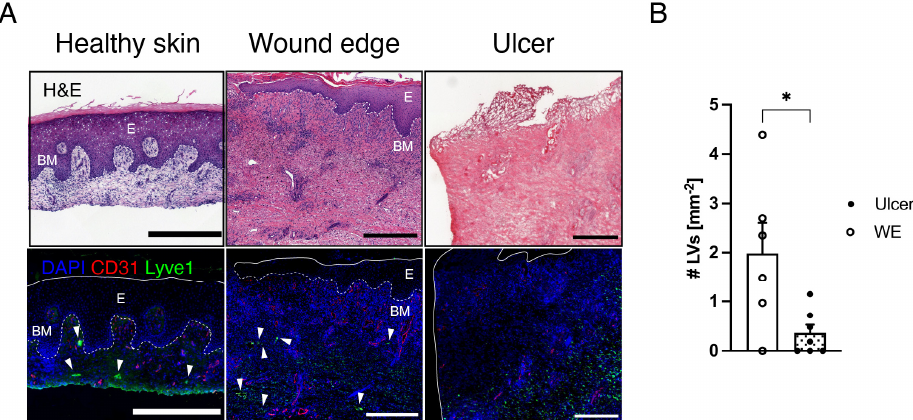
Figure 1. Lymphatic vessels are largely absent in human chronic ulcers. ( A ) Representative H&E and LYVE1 and CD31 stained sections of human healthy skin, wound edge, and ulcer of a chronic wound. Healthy skin is characterized by a continuous basal membrane. The adjacent wound edge is re-epithelialized. The ulcer is defined through its non-epithelialized characteristics. Scale bars: 500 µm. White arrowheads depict LVs. ( B ) Quantification of the number of LVs per mm 2 in representative regions of wound edges adjacent to ulcerative regions and ulcers. N = 6–7. Students t -test, p < 0.05 (*).